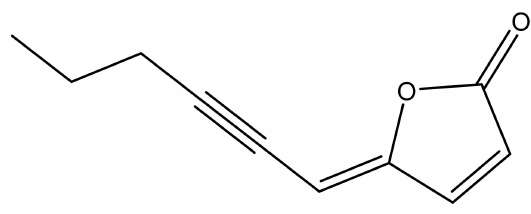
Figure 6. Structure of (4 Z )-lachnophyllum